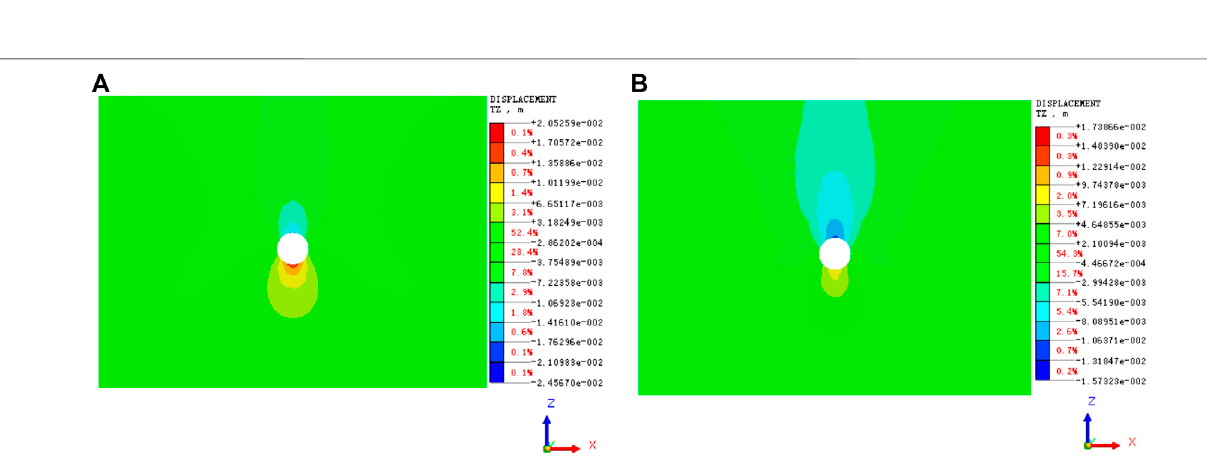
peak of left low right high ” Distribution, and within the length of the tunnel, vertical displacement value from large to small in order for Condition 3, Condition 1, Condition 2; Secondly, Condition 2 and Condition 3 reach the maximum and minimum values of the vertical